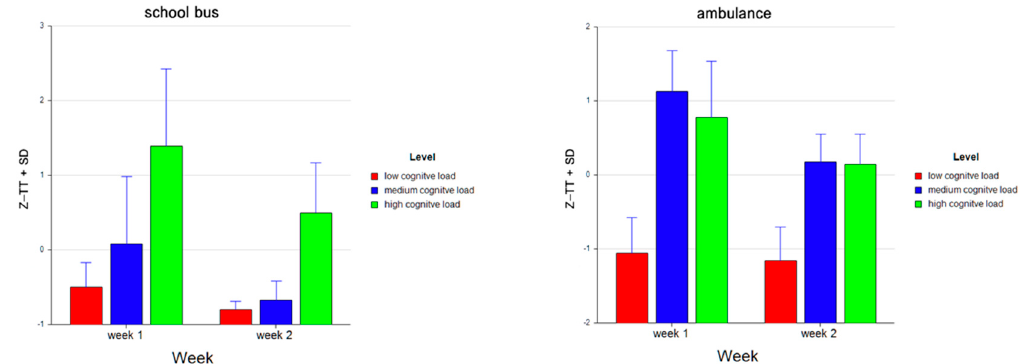
Figure 8. Bar charts represent the average standardized z-scores for total time (Z-TT) and standard deviation (SD) for low cognitive load, medium cognitive load, and high cognitive load tasks for School Bus (left) and Ambulance (right) problem scenarios for Week 1 and Week 2.